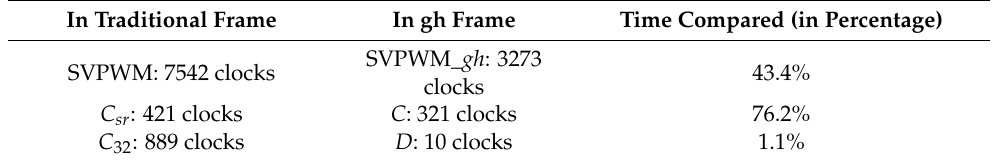
Table 2. Code execution time in two frames.